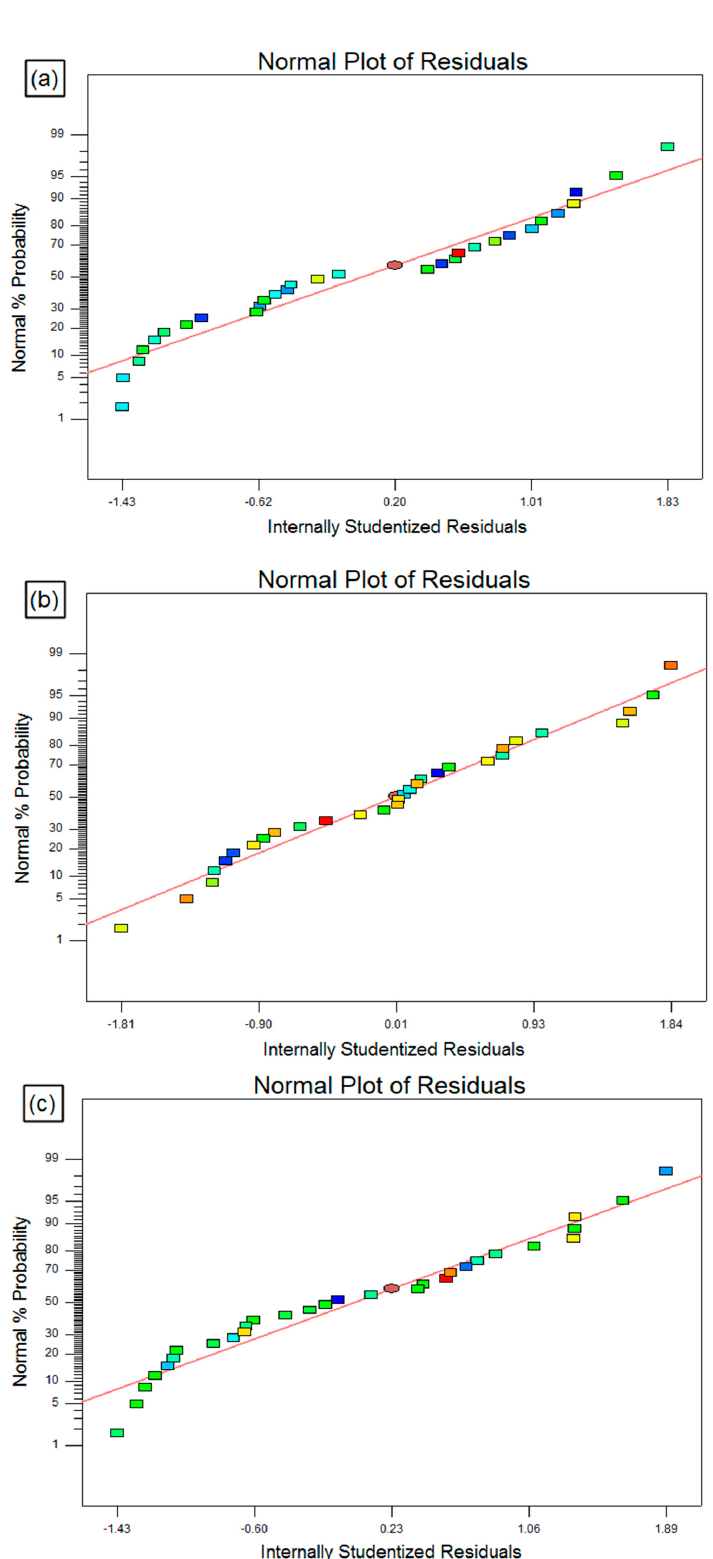
Figure 4. Normal probability residual plots for ( a ) material removal rate (MRR), ( b ) kerf taper (KT), and ( c ) heat affected zone (HAZ).